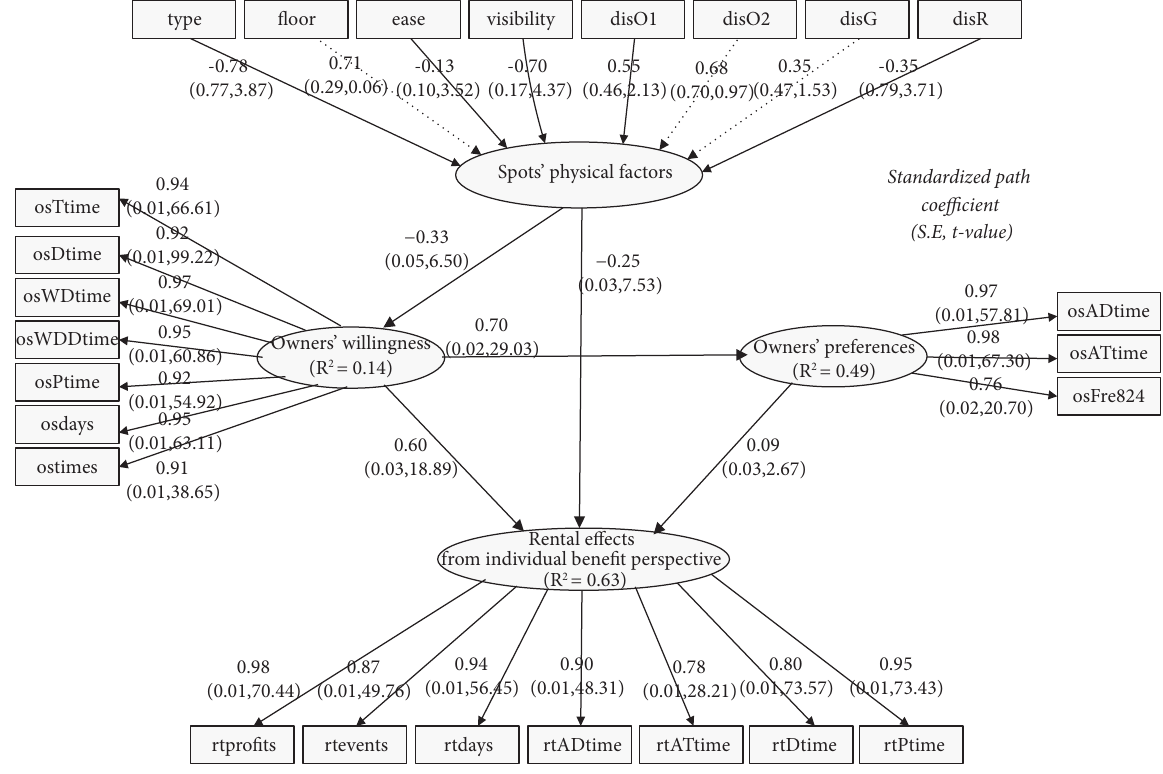
Figure 5: Model structure from an individual benefit Table 2: Effects of latent variables in the individual model.